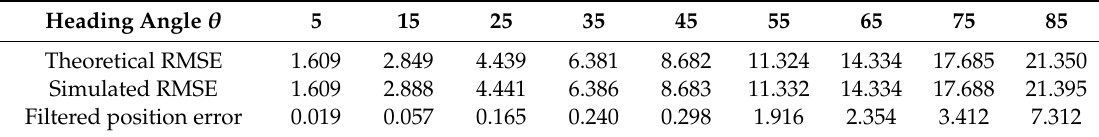
Table 1. Positioning results of Scenario